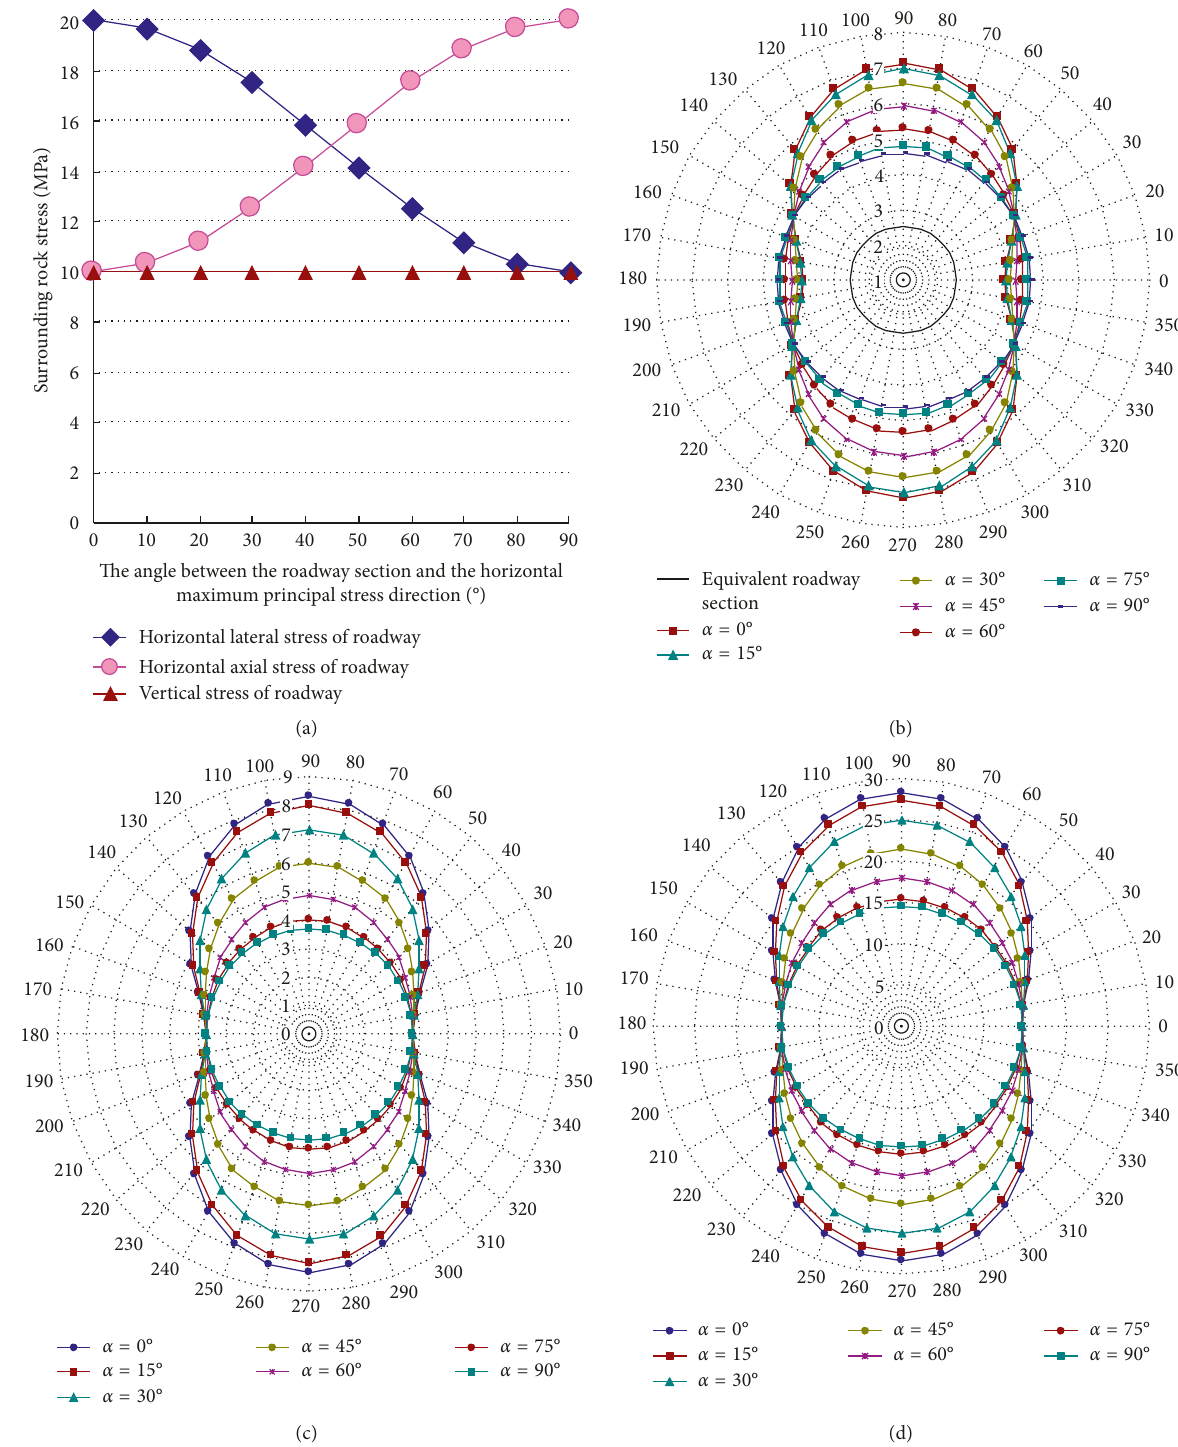
Figure 3: The three-dimensional stress states and change rules of the stress distribution in the surrounding rock plastic zone and plastic zone boundary with the increase of α . (a) Three-dimensional stress state change, (b) plastic failure zone distribution changes, (c) plastic failure zone boundary radial stress distribution change, (d) plastic failure zone boundary tangential stress distribution